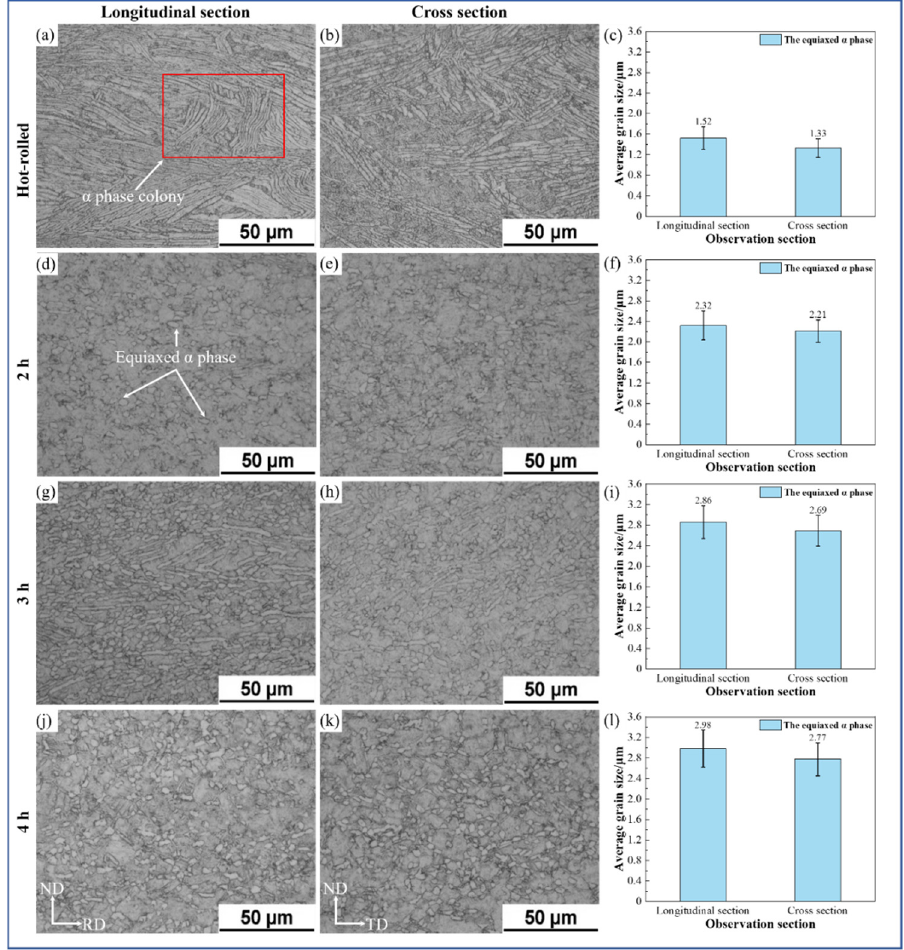
Figure 3. Microstructure and average grain size of TC4 alloy aged sheets.